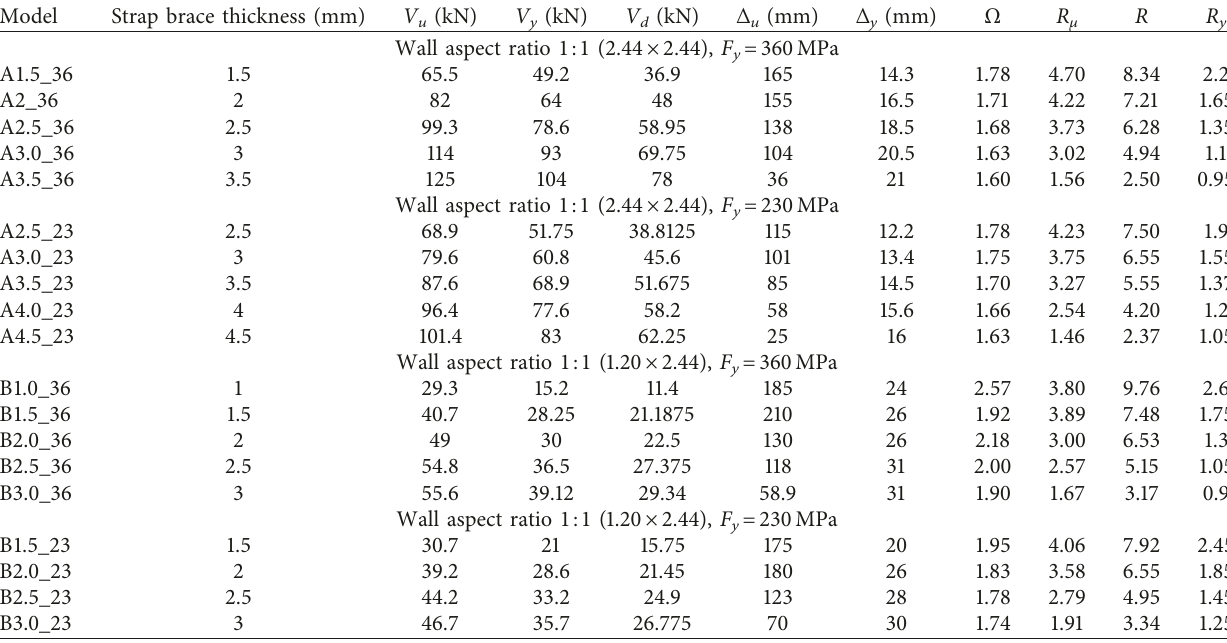
Table 7: Parametric study